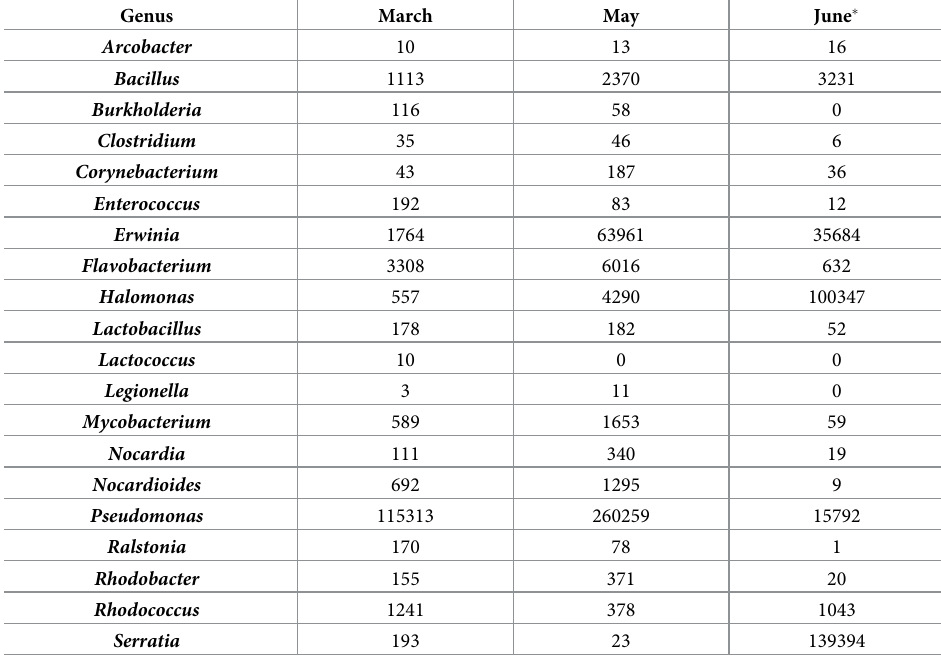
Table 6. List of some potential human and plant pathogenic bacterial sequence tags identified in spinach phyllo- sphere in March, May, and June.